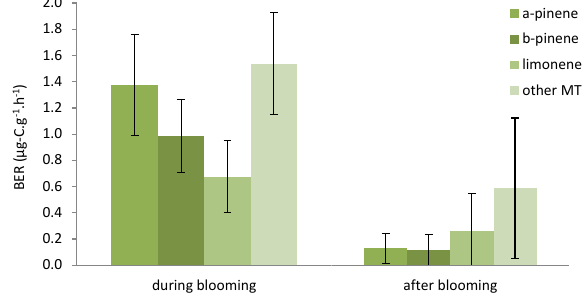
Fig. 9. Comparison of daily averaged and normalized emission rates (30 ◦ C) for α -pinene, β -pinene and limonene, and other monoter- penes from honey locust during and after the flowering period. Error bars represent 95 percent confidence intervals.